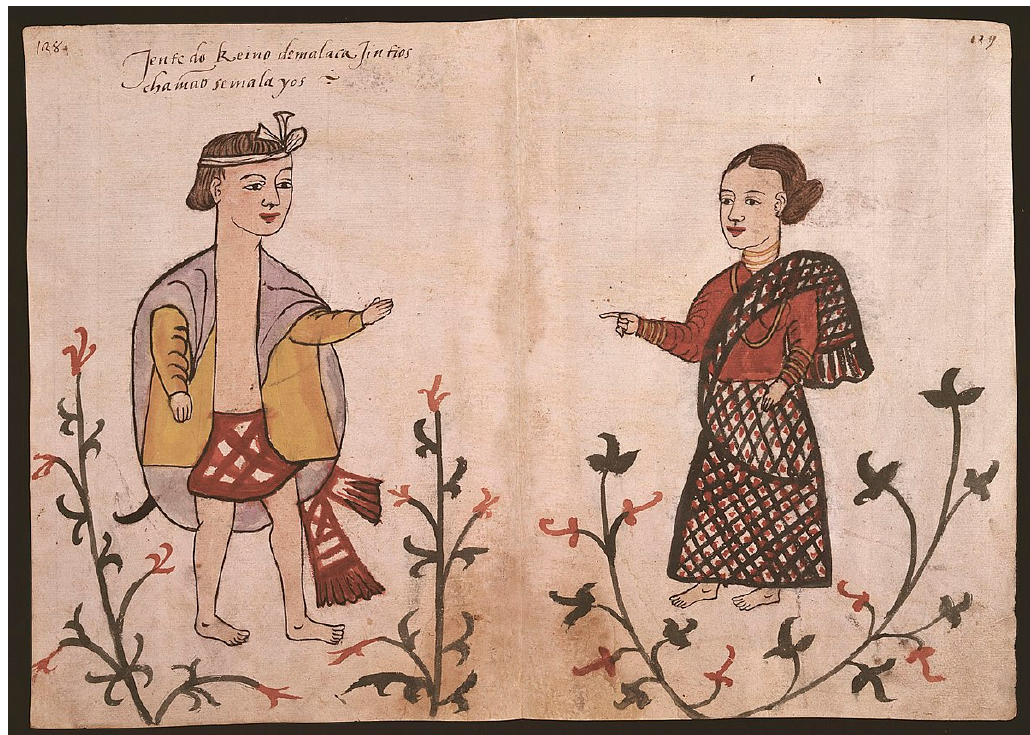
Figure 1. A sixteenth-century Portuguese illustration of Malays, described as “people from the Kingdom of Melaka”. Album di disegni, illustranti usi e costumi dei popoli d’Asia e d’Africa con brevi dichiarazioni in lingua portoghese, Ms. 1889, 1540, Biblioteca Casanatense, Rome, http://opac.casanatense.it/Record.htm?Record=19921796124917499789 (17 March 2020).